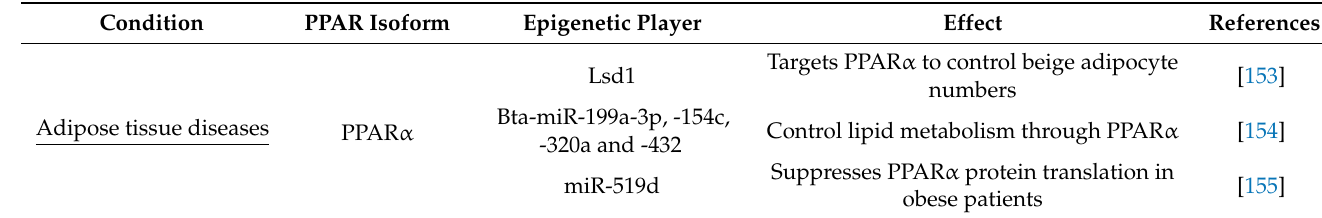
Table 4. PPAR α epigenetics in adipose tissue